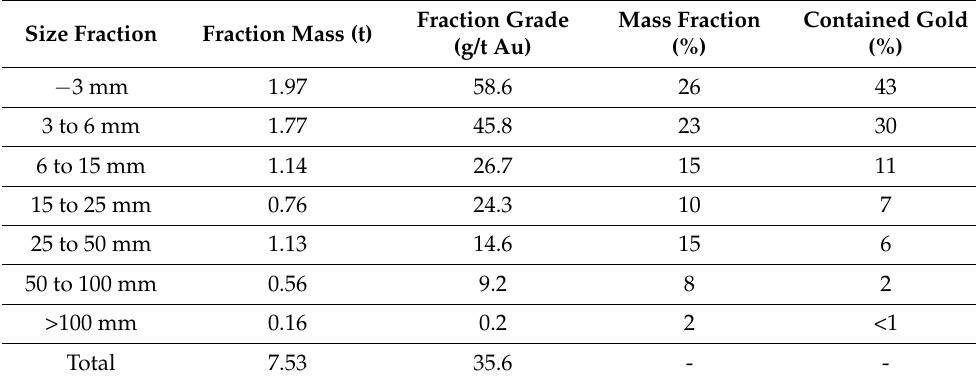
Table 7. Granulometric analysis of a bulk sample of drive residue.